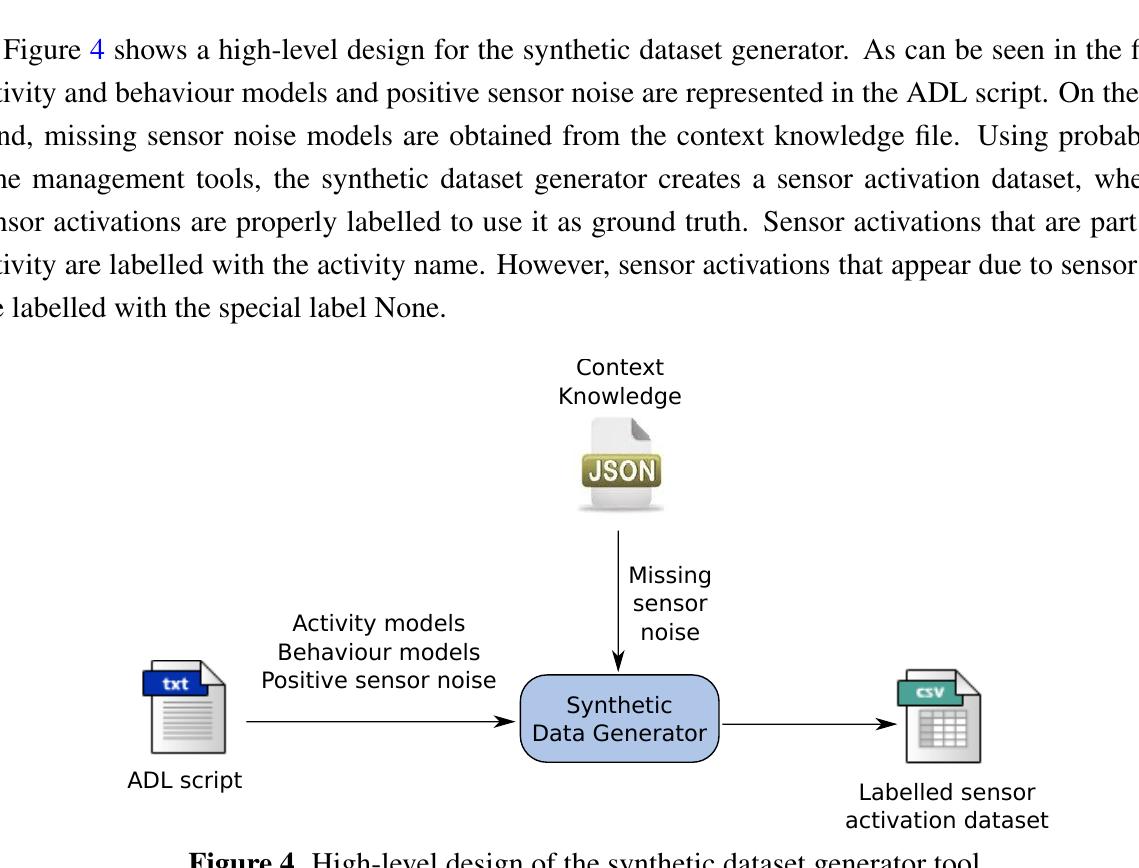
Figure 4. High-level design of the synthetic dataset generator